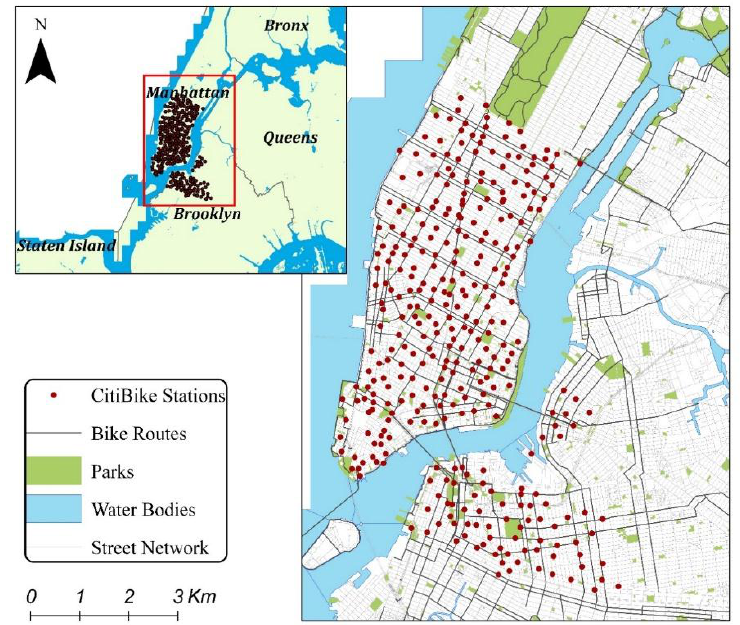
Figure 1. CitiBike stations in New York